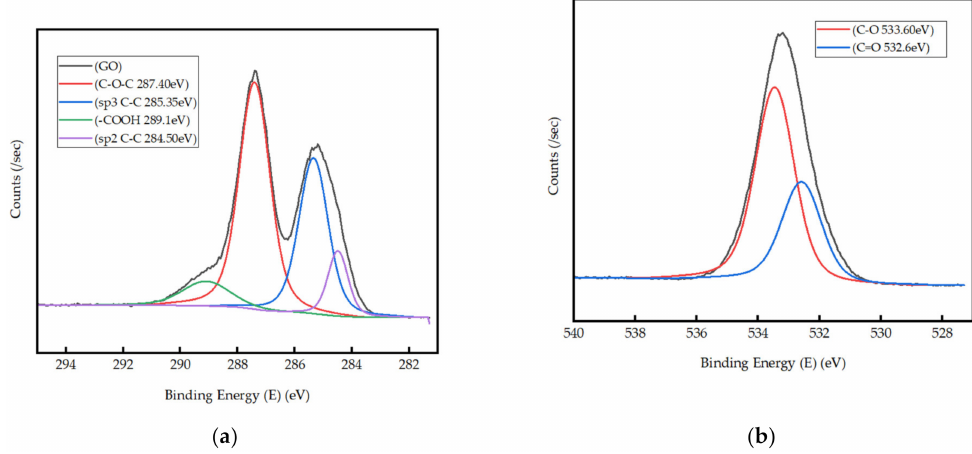
Figure 3. ( a ) Narrow XPS of C1s; ( b ) Narrow XPS of